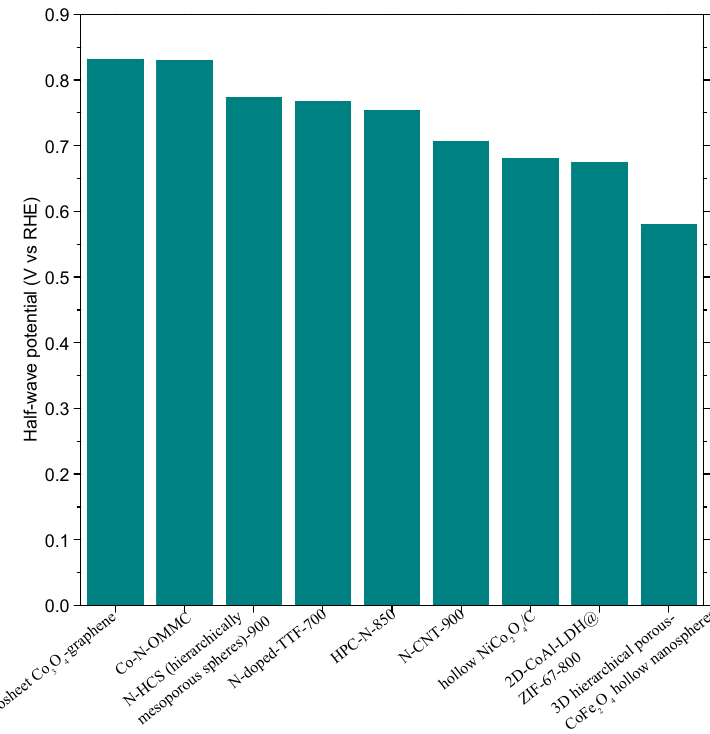
Figure 2. Comparison of half-wave potential (V vs. RHE). (References from left to right column: [38],